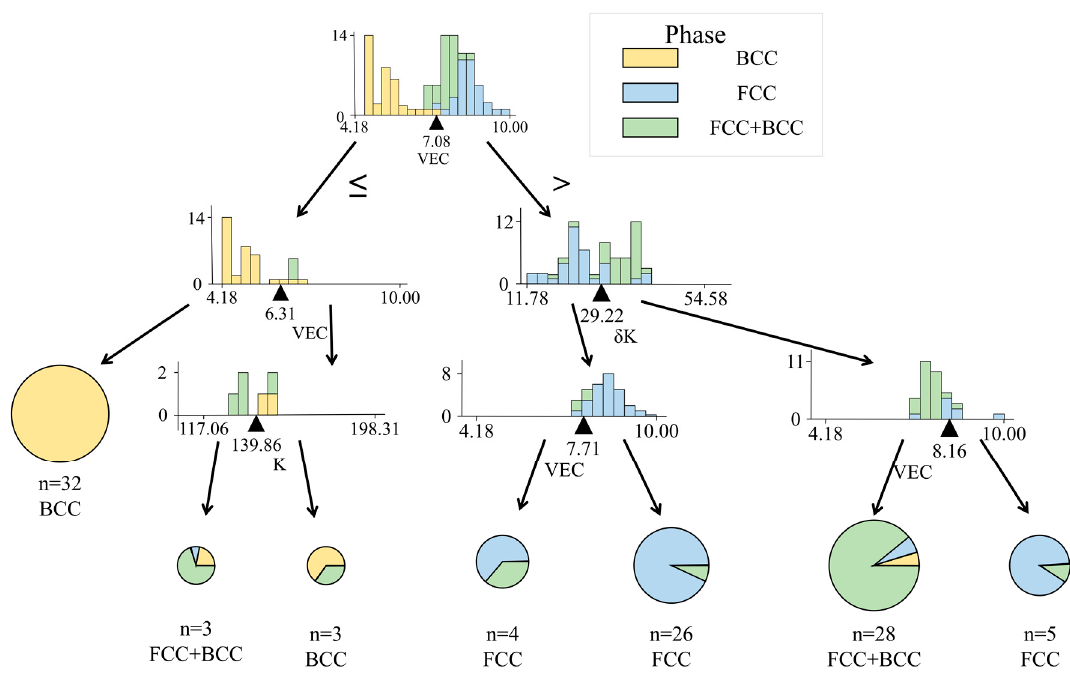
Figure 8. Visualize the decision-making process of the Decision Tree in test set.